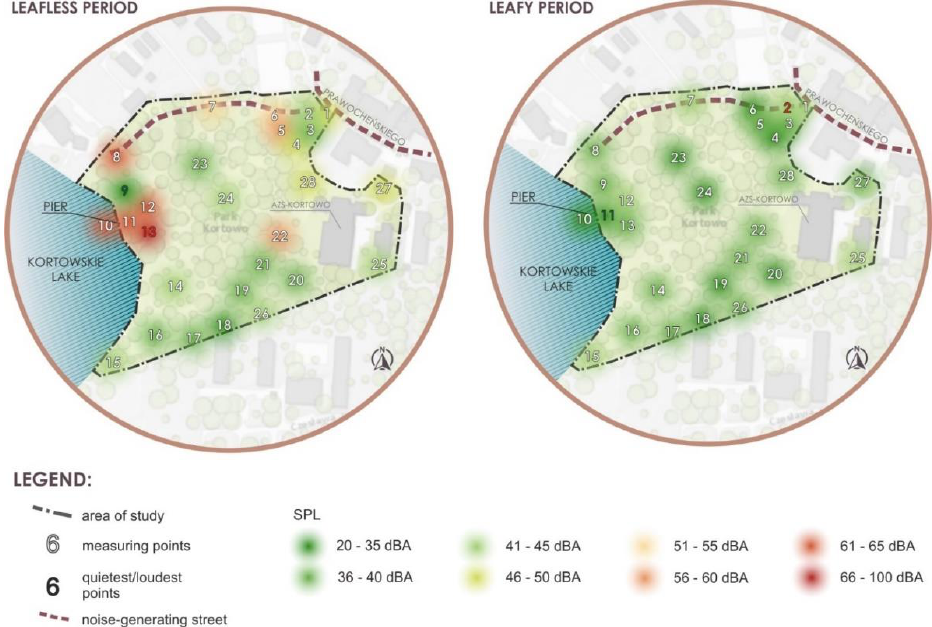
Figure 4. Results of evaluation of the soundscape (SPL measurements) presented in a map of the Kortowo Park in the leafless and leafy period. Traffic is the main source of noise. In the leafless period, point 9 is the quietest, and point 13 is the loudest. In the leafy period, point 11 is the quietest, and point 2 is the loudest.